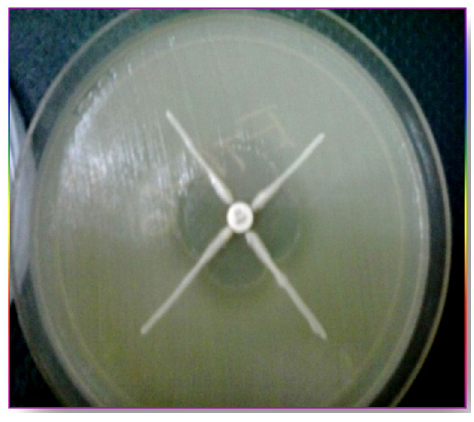
Plate 1. Mueller Hinton agar plate showing Modified hodge test